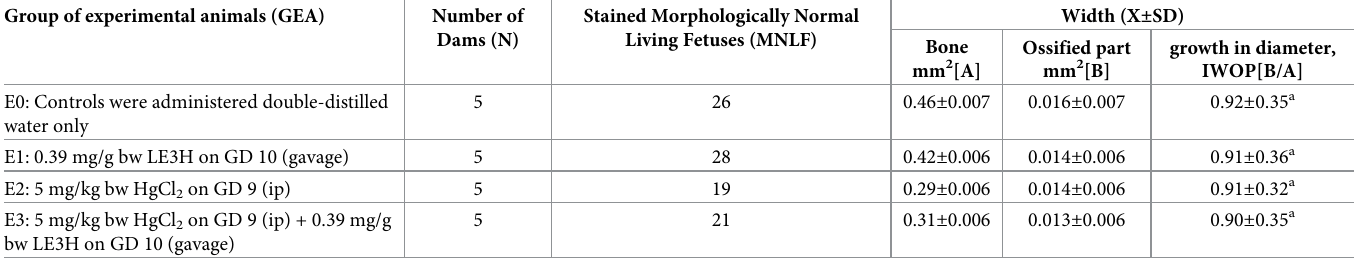
Table 6. Width of femur bone of M . musculus fetuses on Gestation Day (GD) 18 which previously were given 0.39 mg/g bw LE3H through gavage on GD 10 (E1), injected with 5 mg/kg bw HgCl 2 on GD 9 (E2), and administered 5 mg/kg bw HgCl 2 on GD 9 and then 0.39 mg/g bw LE3H on GD 10 (E3). Meanwhile, the controls (E0) were administered double-distilled water only. Group of experimental animals